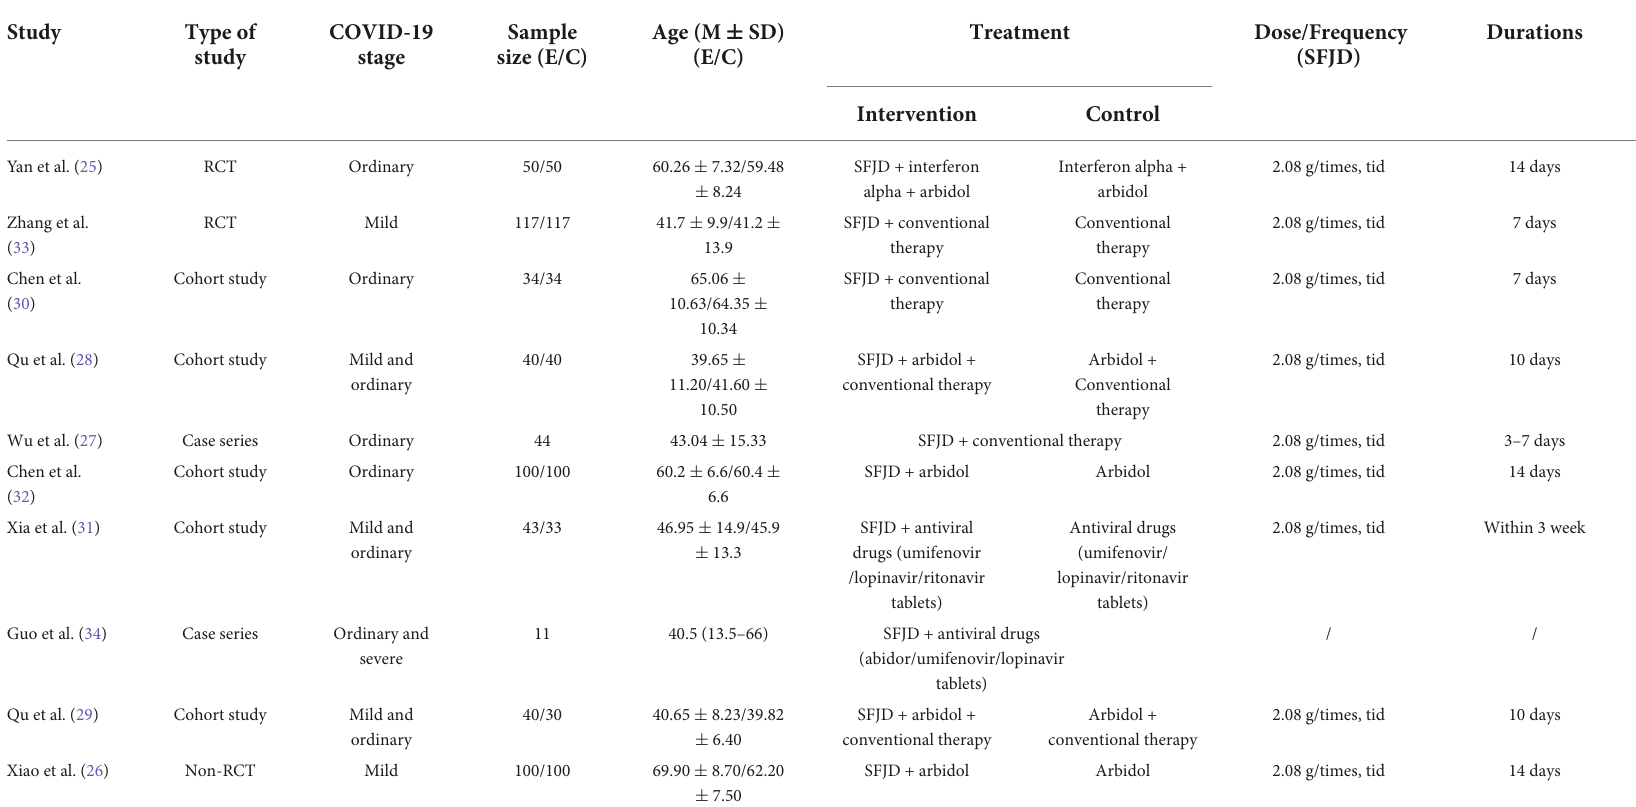
TABLE 1 General characteristics of the included